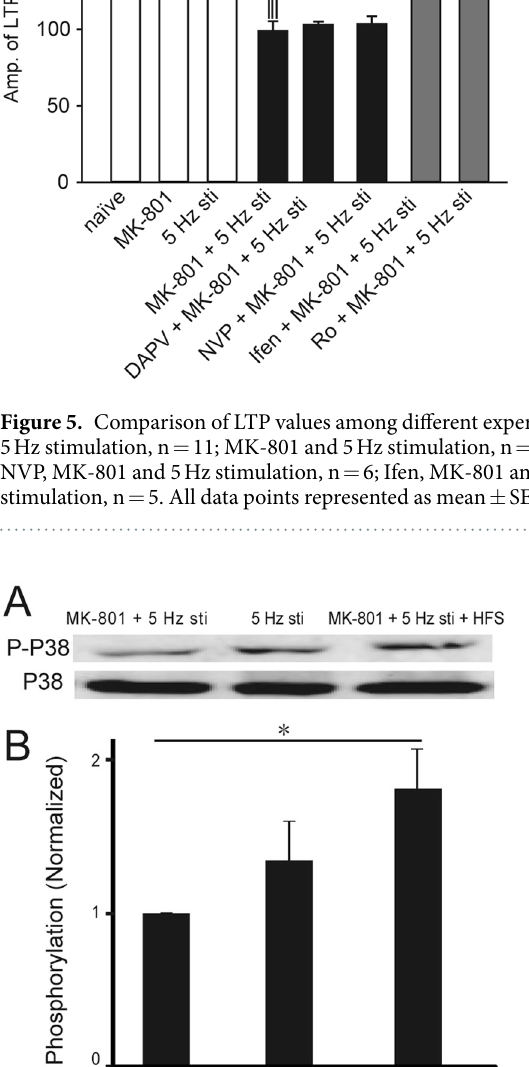
6 Scientific RepoRts | 7: 3045 | DOI:10.1038/s41598-017-03287-7